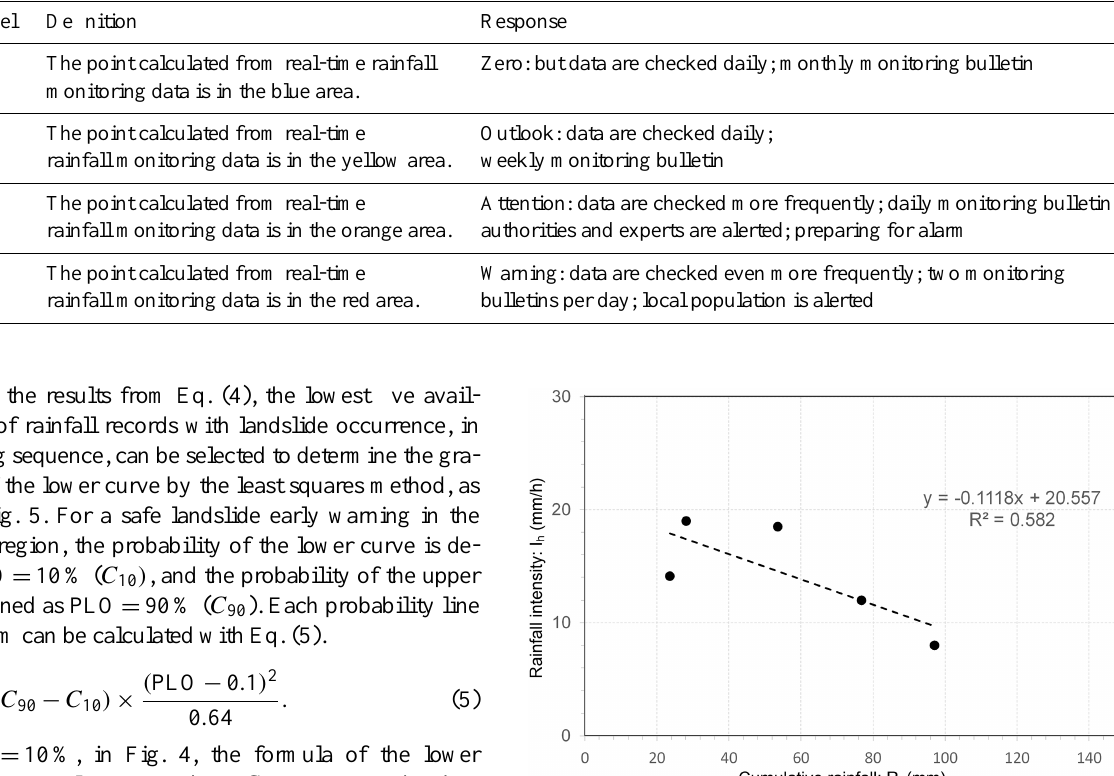
Table 2. Recommended warning levels and responses.